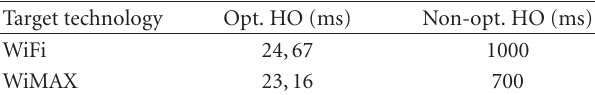
Table 4: Handover